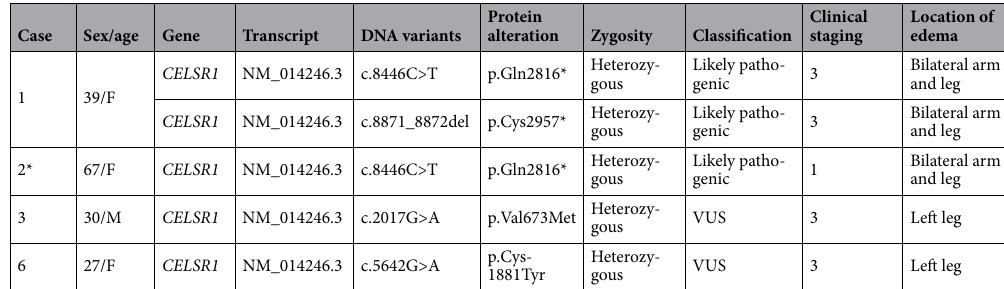
Table 2. Genetic and clinical profiles of 4 patients with genetic abnormalities detected in CELSR1 . All 4 variants were not found in the general population (gnomAD). VUS variant of uncertain significance, gnomAD Genome Aggregation Database. *Case 2 is mother of case